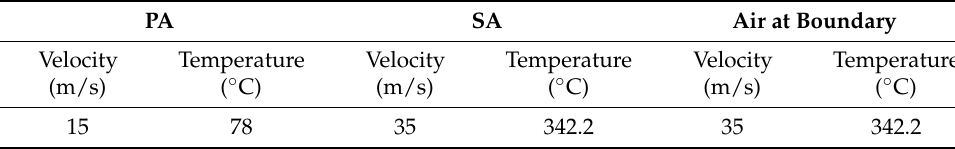
Table 3. Burner operating parameters in the supercritical